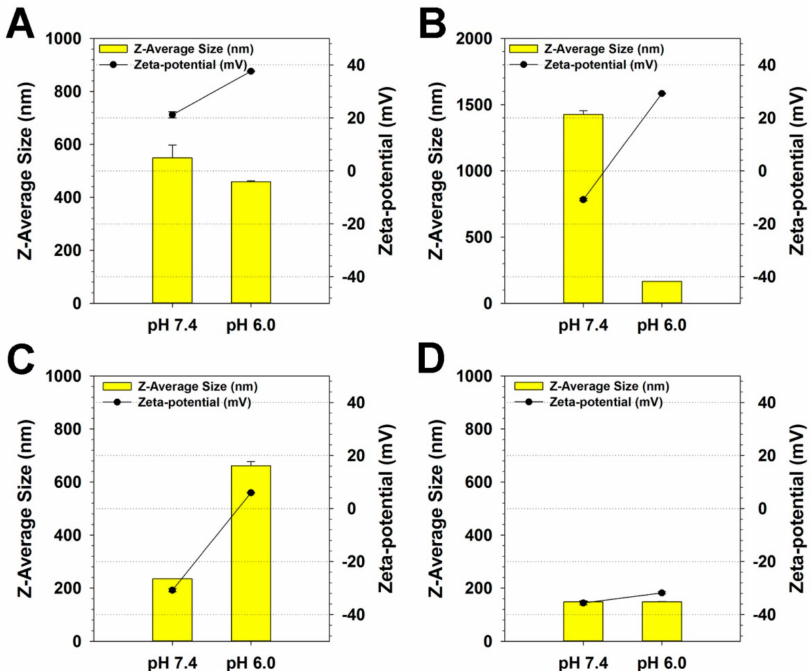
Figure 2. Z-average sizes and zeta-potential values of PKE(PEI-rGO) nanostructures at pH 7.4 and 6.0. polymer coating ratio was set to a weight ratio of 30. Data are shown as the mean ± S.D ( n =